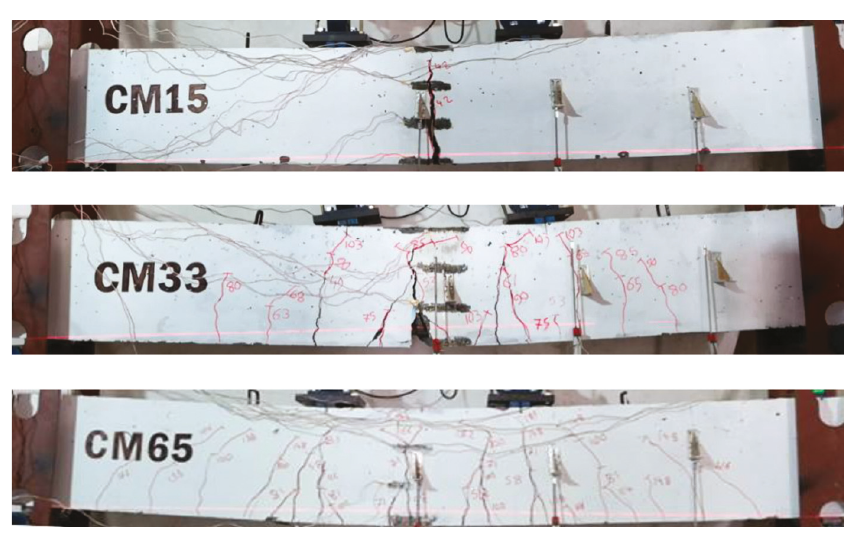
Figure 10: Crack propagation of medium